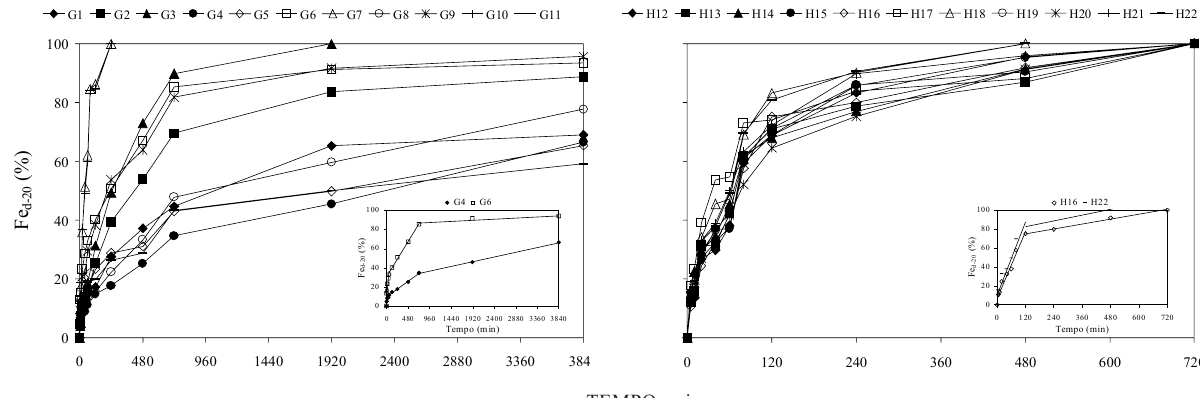
Figura 2. Percentagem de ferro dissolvido ao longo das dissoluções seletivas das amostras goethíticas (a) e hematíticas (b). No detalhe, curvas de dissolução segmentadas em intervalos lineares das amostras goethíticas G4 e G6 (a) e hematíticas H16 e H22 (b).